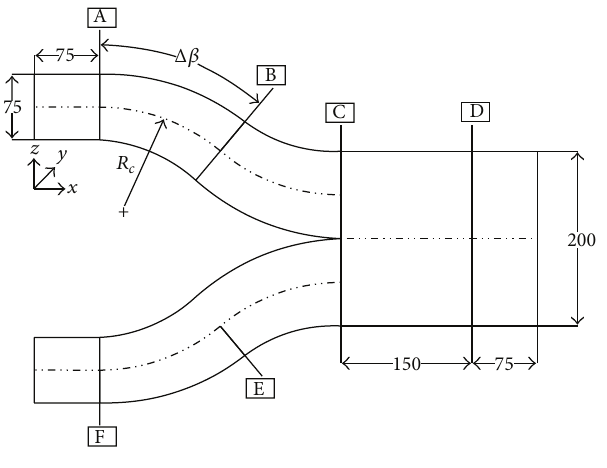
Figure 1: Schematic diagram of a twin air-intake.